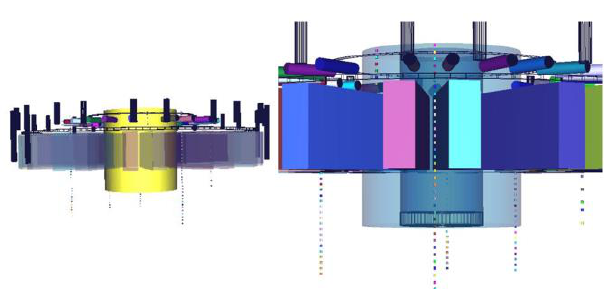
Figure 2. Visual representation of detector positions at various penetrations around the vault, as plotted in